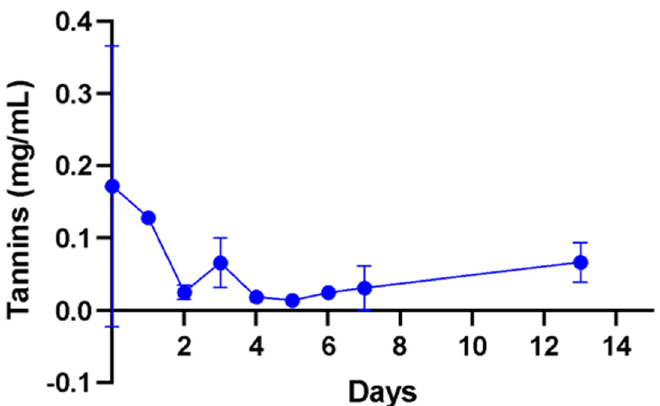
Figure 3. Change in titratable acid and pH measured in wine during fermentation and storage process. A sudden decrease in tannin concentration from 0.33 to 0.02 mg/mL between days 0 and 2 was observed (Figure 4). Notably, a gradual increase in tannin content was observed from days 5–13.